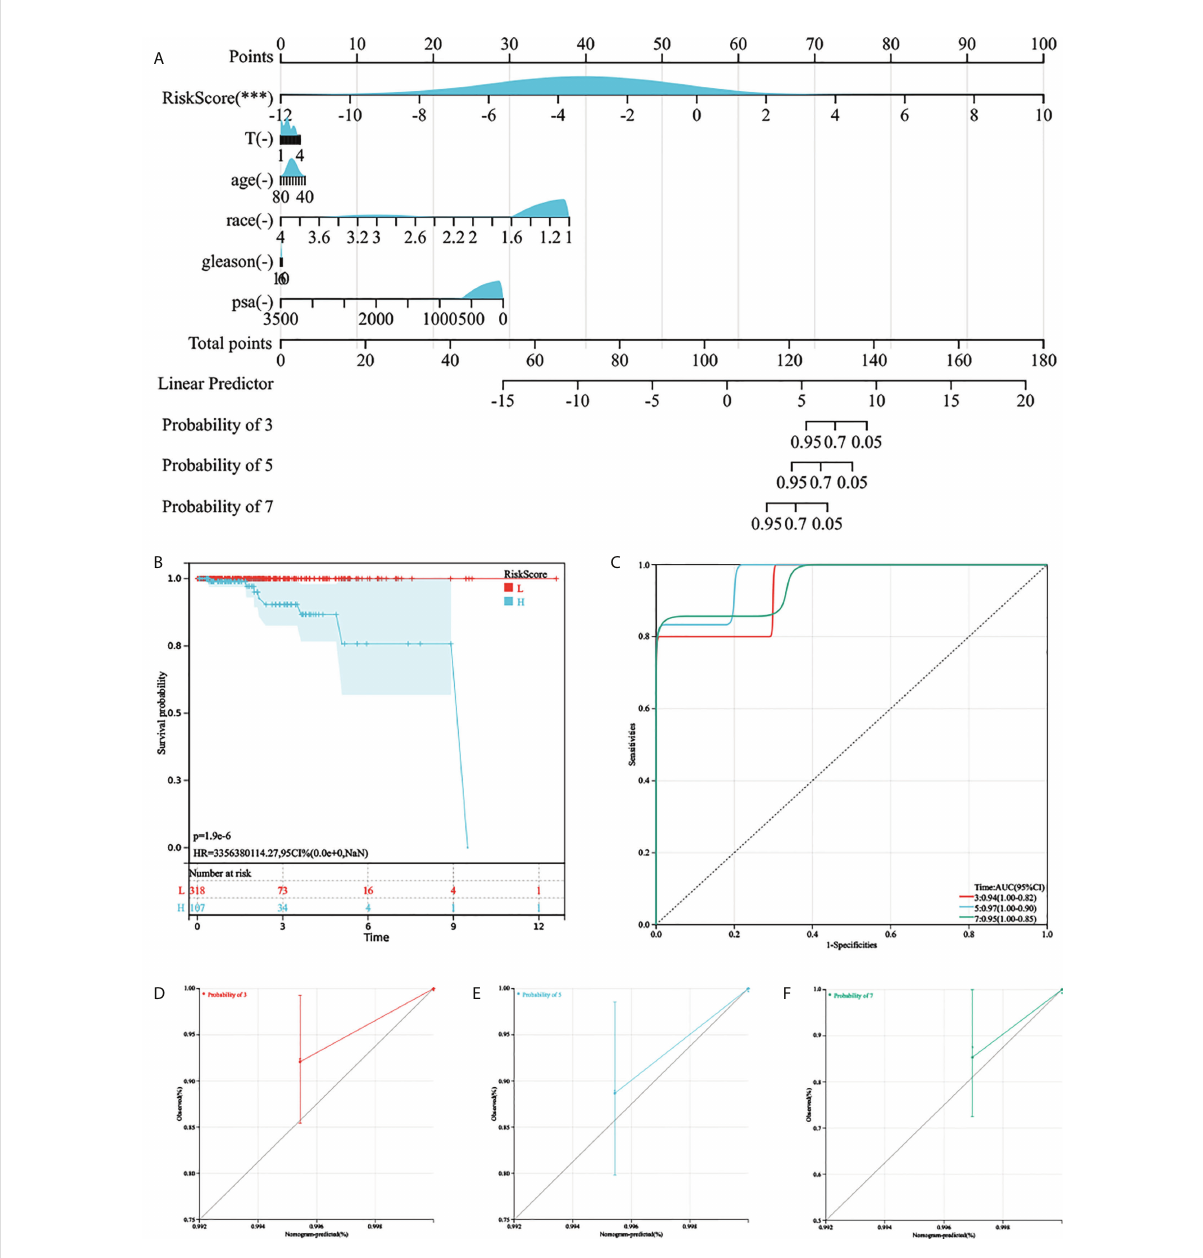
FIGURE 5 The nomogram was generated to improve risk strati fi cation and estimate survival probability. (A) The comprehensive nomogram for predicting probabilities of PC patients with 3-, 5-, and 7-year OS in TCGA-PRAD cohort. (B, C) Kaplan – Meier analysis and ROC curves of 3-, 5-, and 7-year OS for this nomogram. (D – F) The calibration plots for predicting PC patients with 3-, 5-, and 7-year OS in TCGA-PRAD